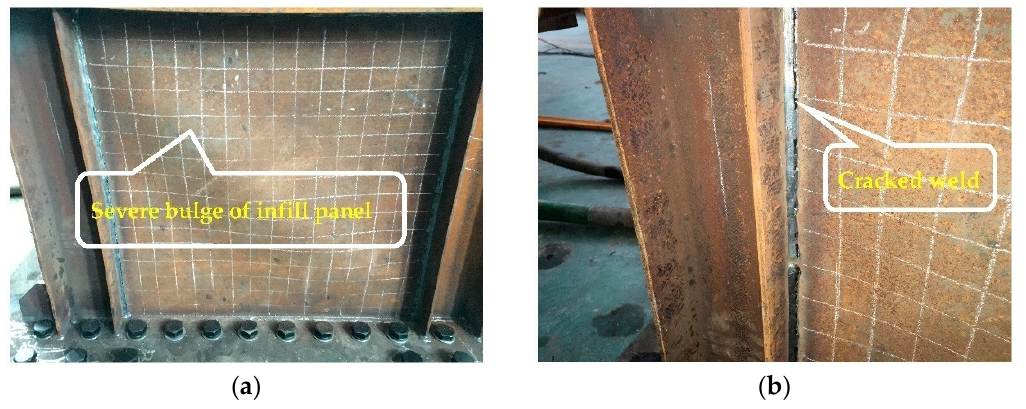
Figure 17. Structural deformation of specimen 1 after the termination of the experiment: ( a ) Infill panel; ( b ) Weld between infill panel and frame column.